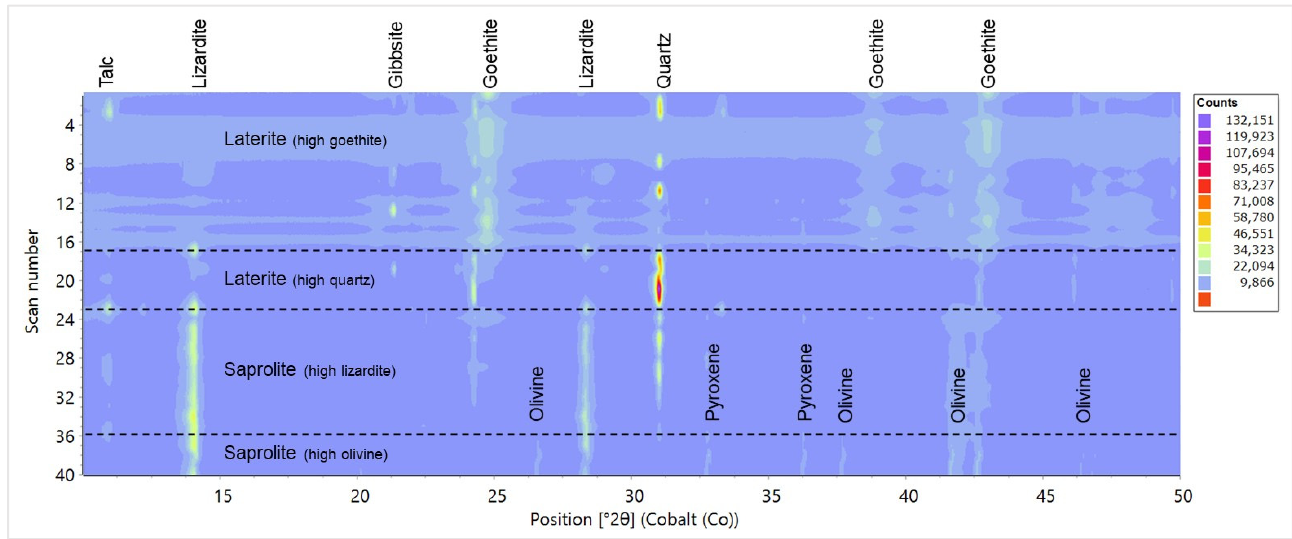
Figure 8 gives an overview of all XRD measurements from the lateritic profile as a surface plot. Different colors indicate the different intensities of the peak of the minerals. The upper laterite horizon of the profile is dominated by the oxide minerals, while in the lower saprolite horizon secondary and primary silicates are the main minerals.